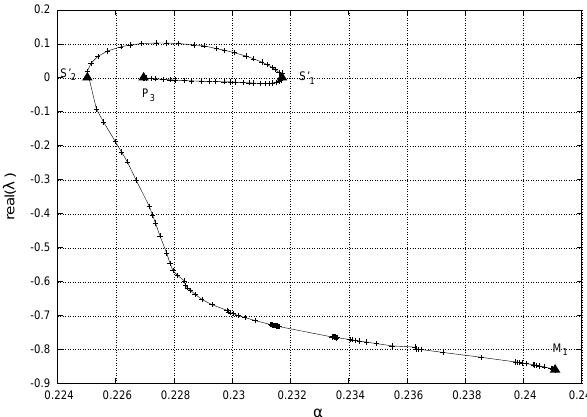
Fig. 15: Evolution of the leading real eigenvalue λ 0 along the branch that arises from the pitchfork bifurcation P 3 inFig.11andontothemergingpoint M 1 ;sameconventionsasinFig.8. Thehigher density of the points along certain segments of the curve in this figure reflects the continuation algorithm’s slower convergence near those α -values. The eigenvector associated with the pitchfork bifurcation at P 3 appears in Fig. 16a, while those associated with the saddle-node bifurcations S ′ 1 and S ′ 2 are shown in Figs. 16b and 16c, and those justbeforethemergingpoint M 1 inFig.16d. InallfourpanelsofFig16,thesymmetriccomponent oftheeigenvectorisdominant. ThestrongresemblancebetweenFigs.16aand9atendstoprovethat 575 all pitchfork bifurcations in the atmospheric model arise due to the same eigenvector. The eigenvector in Fig. 16a here, however, is less concentrated near the jet axis, and its stream function anomalies remain slightly larger even far from the jet axis. At M 1 , though, the eigenvector inthepreviouscase. Still,thelargestamplitudesofthestreamfunctionareconcentratednearthejet 580 axis and maintain an oscillation of the latter around its equilibrium position.